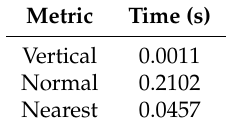
Table 5. Execution times of each designed